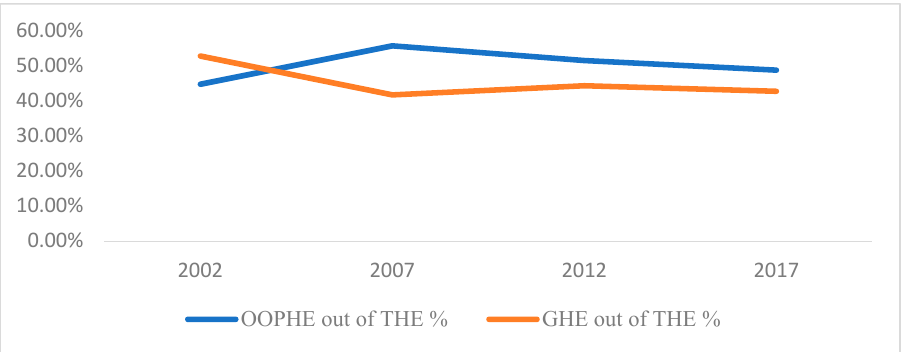
Figure 4. Change in OOPHE and GHE as a percentage of THE.